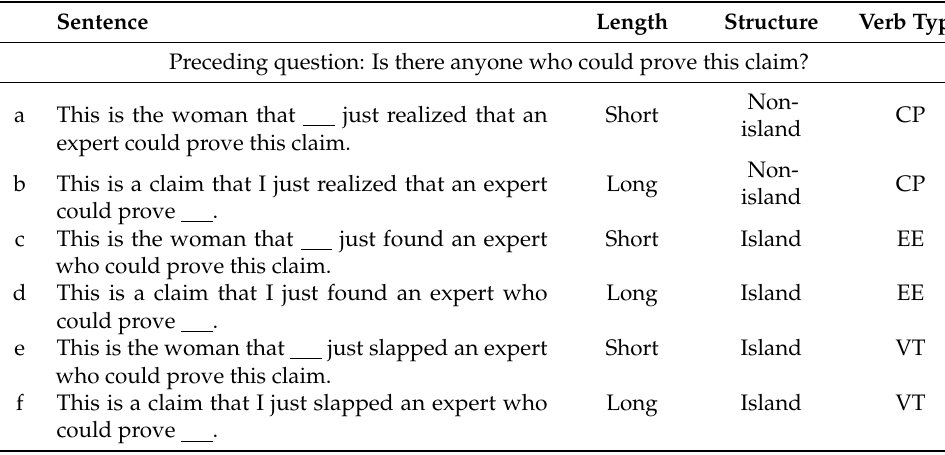
Table 3. Experiment 2 sample